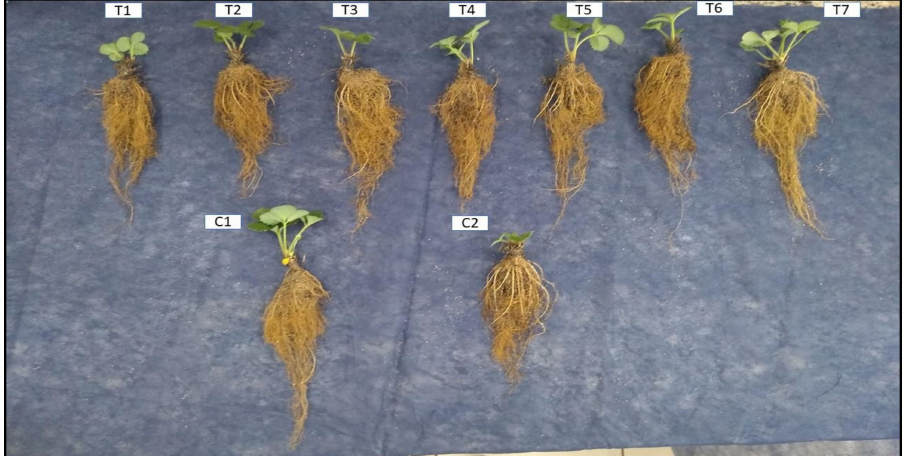
250.46 ± 25.46a ⬤ 〇 1.46 ± 0.21a ⬤ 〇 6.24 ± 0.88ab ⬤ 〇 0.037 ± 0.007a ⬤ 〇 Closed ( ⬤ ) and open ( 〇 ) circles indicate comparisons withs Controls 1 and 2, respectively. Green, yellow, and red circles indicate that the values are higher than, equivalent to, or lower than those observed in the controls, according to the Kruskal–Wallis test ( p ≤ 0.05) and pairwise comparison with the Dunn test ( p ≤ 0.05). Means followed by the same letter do not differ statistically. Control 1: control without inoculation + fertilization 100% of N and P; Control 2: control without inoculation + fertilization 30% of N and P; Treatment 1: Azospirillum brasilense (Ab-v5), Treatment 2: Bacillus megaterium (0004); Treatment 3: Brevibacillus fluminis (MET12M2); Treatment 4: Ab-v5 + 0004; Treatment 5: Ab-v5 + MET12M2; Treatment 6: 0004 + MET12M2; Treatment 7: Ab-v5 + 0004 + MET12M2.